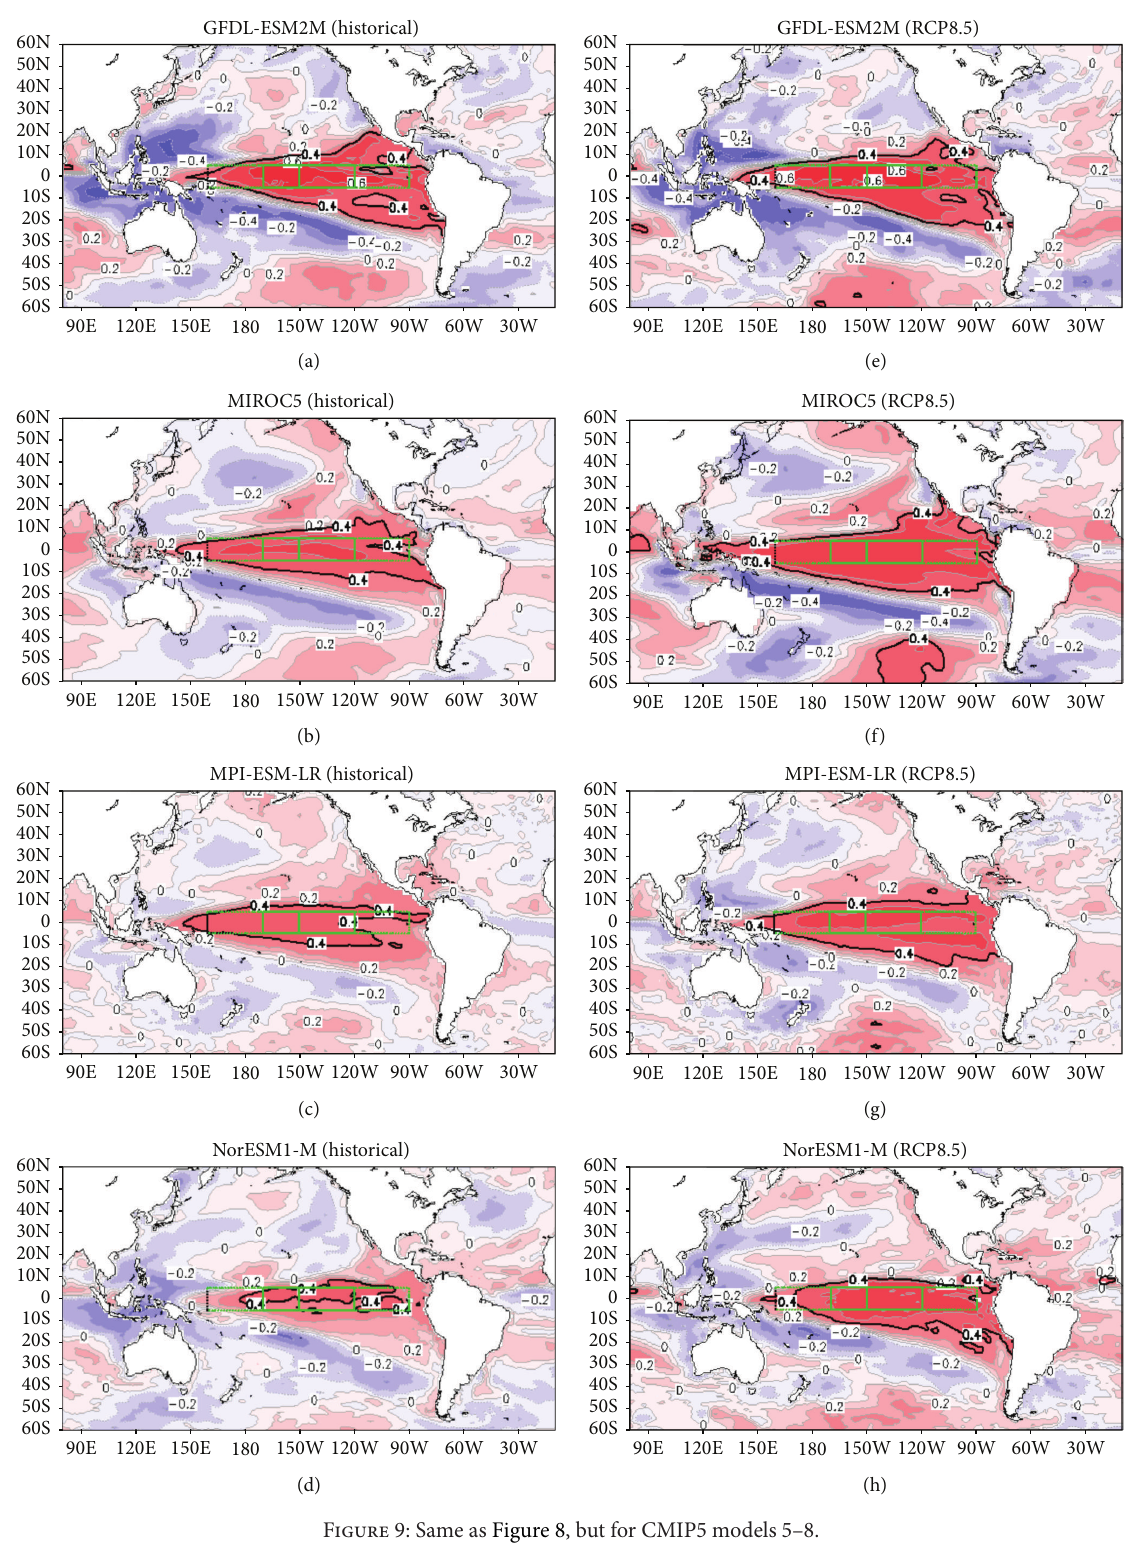
Figure 9: Same as Figure 8, but for CMIP5 models